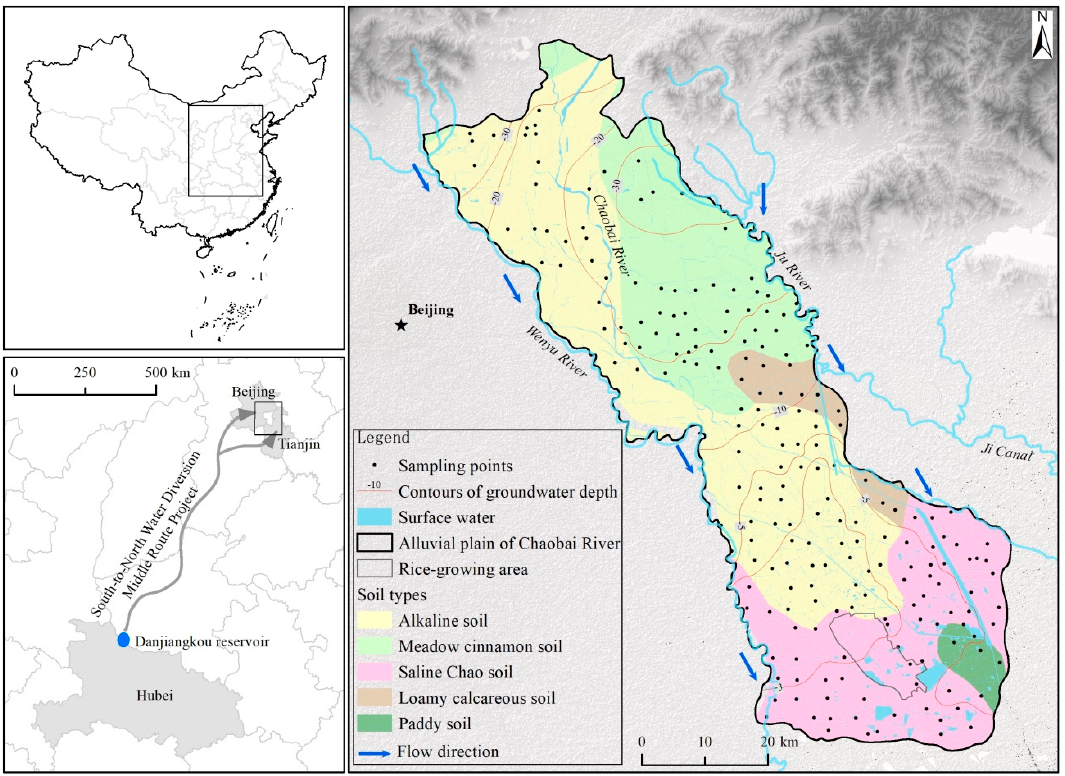
Figure 1. Location of the Chaobai River Basin (CBR) and the sampling points in relation to the South–North Water Diversion Project (middle route). Contours of groundwater depth and surface water such as rivers and canals are also shown.